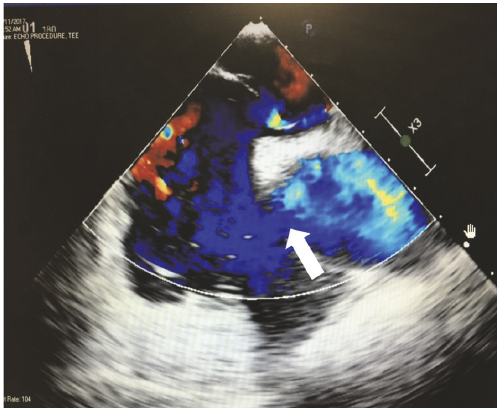
Figure 5: Transesophageal echocardiogram showing significant R to L shunt (white arrow).